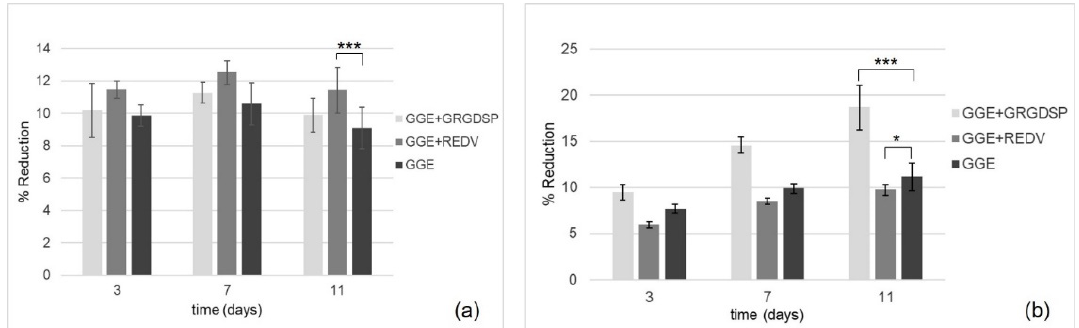
Figure 8. Alamar Blue reduction percentage as a function of culture times for scaffolds seeded with HUVEC ( a ) and HDF ( b ). GRGDSP-modified scaffolds (GGE+GRGDSP) and REDV-modified scaffolds (GGE+REDV) were compared with unmodified scaffolds (GGE). The data (n = 9; error bars ± SD) were compared using Student’s t -test and differences were considered significant when * p < 0.05, *** p < 0.001.